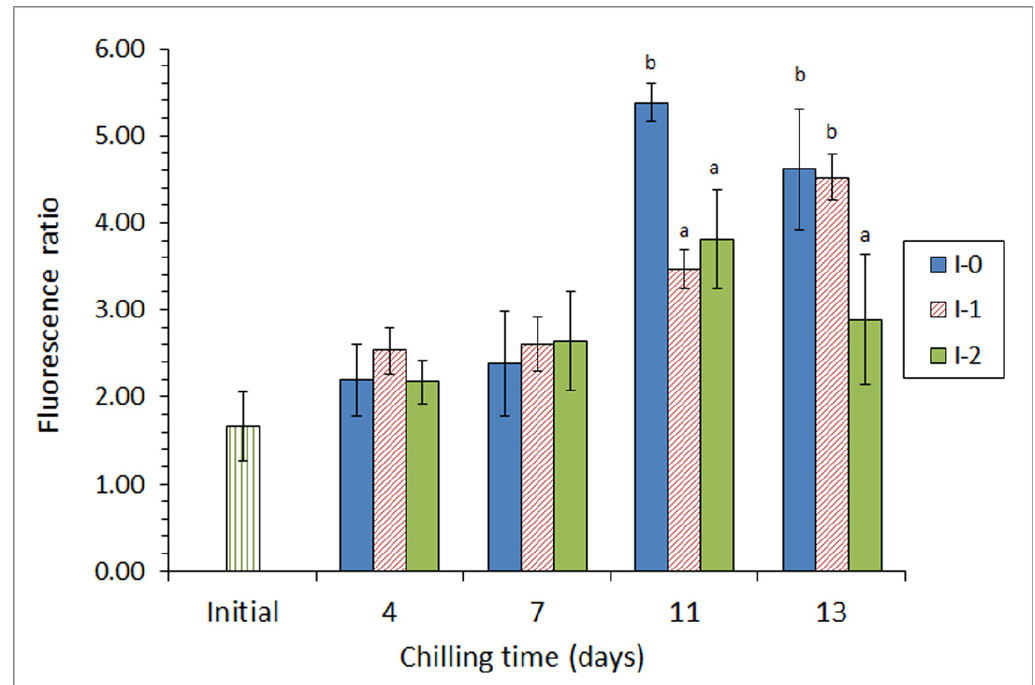
Figure 3. Evolution of the fluorescence ratio * in chilled megrim subjected to different icing conditions **. * Average values of three independent determinations ( n = 3). Standard deviations are indicated by bars. Average values accompanied by different letters indicate significant differences ( p < 0.05). ** Icing conditions: I-0 (traditional ice; control), I-1 (ice including a low concentration of the alga extract), and I-2 (ice including a high concentration of the alga extract). Adapted from García-Soto et al. [69].